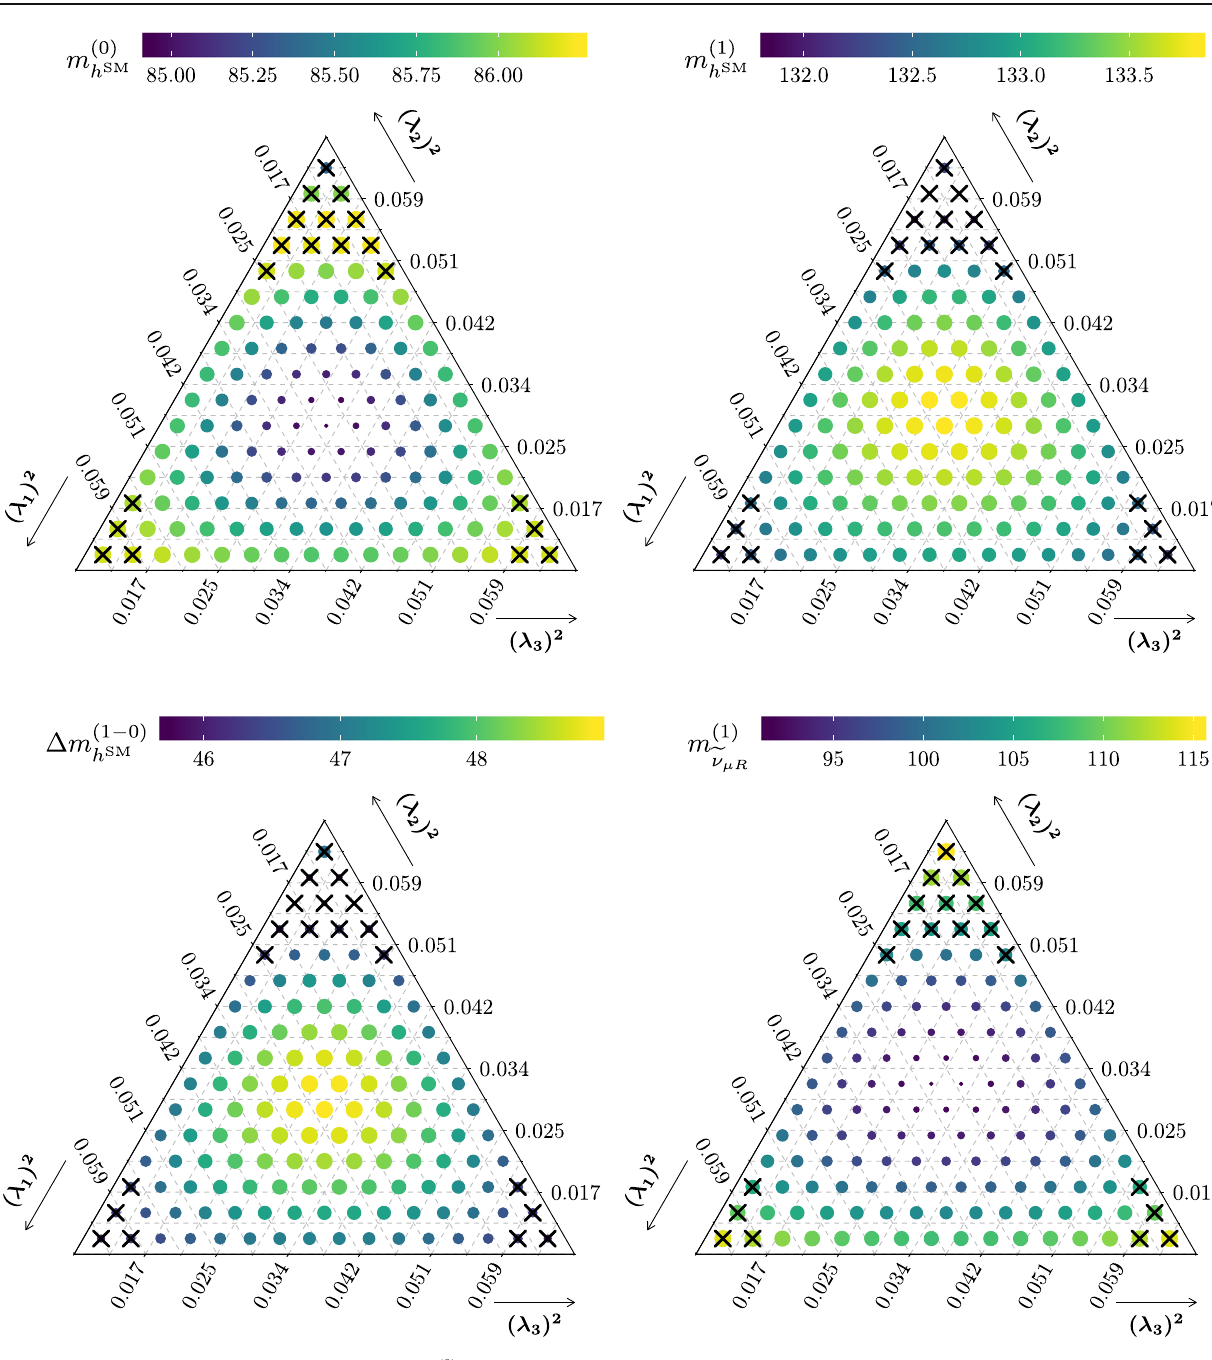
≥ 150 / 101 = 1 . 485 for red